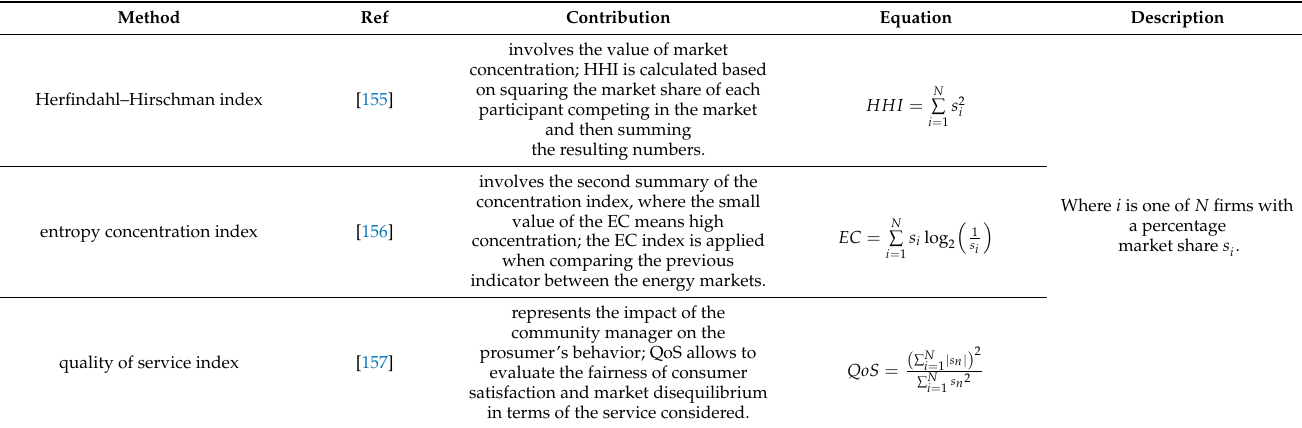
Table 5. More common competition indices used for describing energy